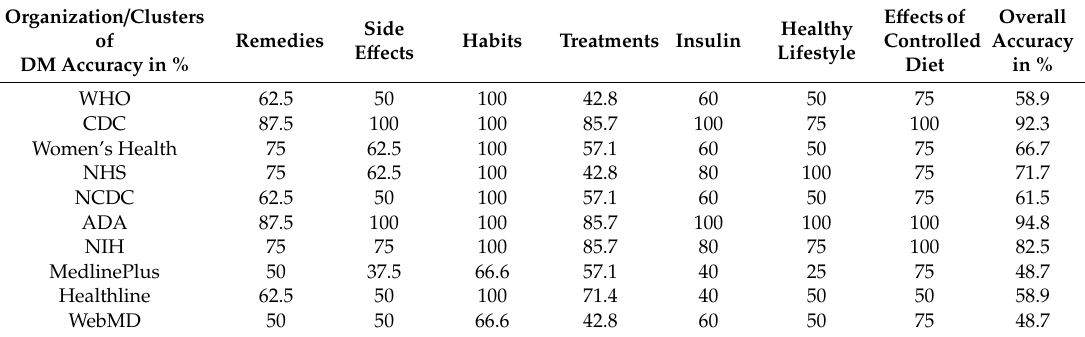
Table 4. Comparison of DM keywords with di ff erent healthcare organization.